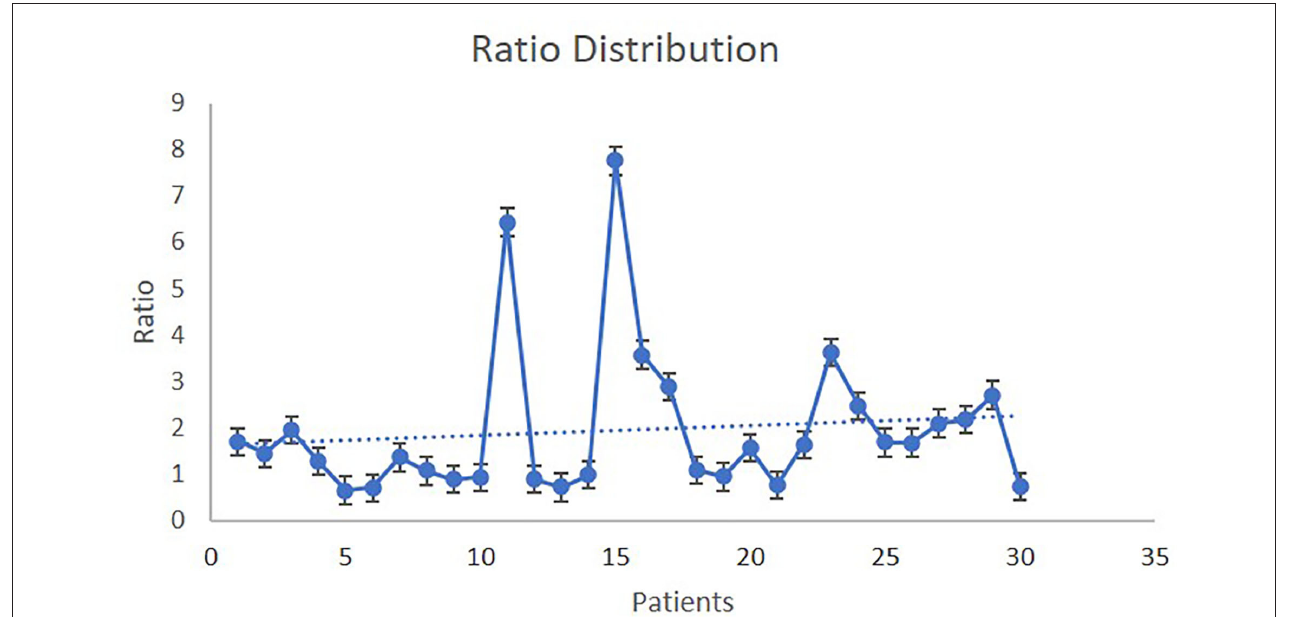
FIGURE 1 | The SUVmax of the lesion/SUVmax of mediastinal tissue ratio